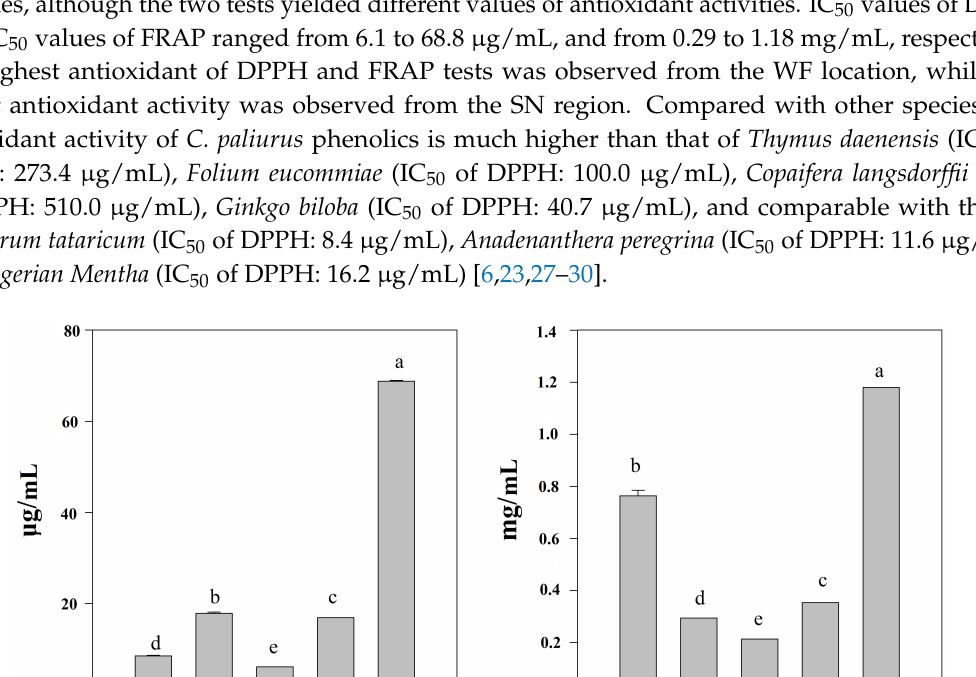
Figure 4. Antioxidant index of C. paliurus phenolics from sampling locations (JZS, MC, WF, MW, and SN) in diabetic model mice. Columns having different letters are significantly different at p < 0.05. DC: diabetic control group; NC: normal control group; PC: positive control group.